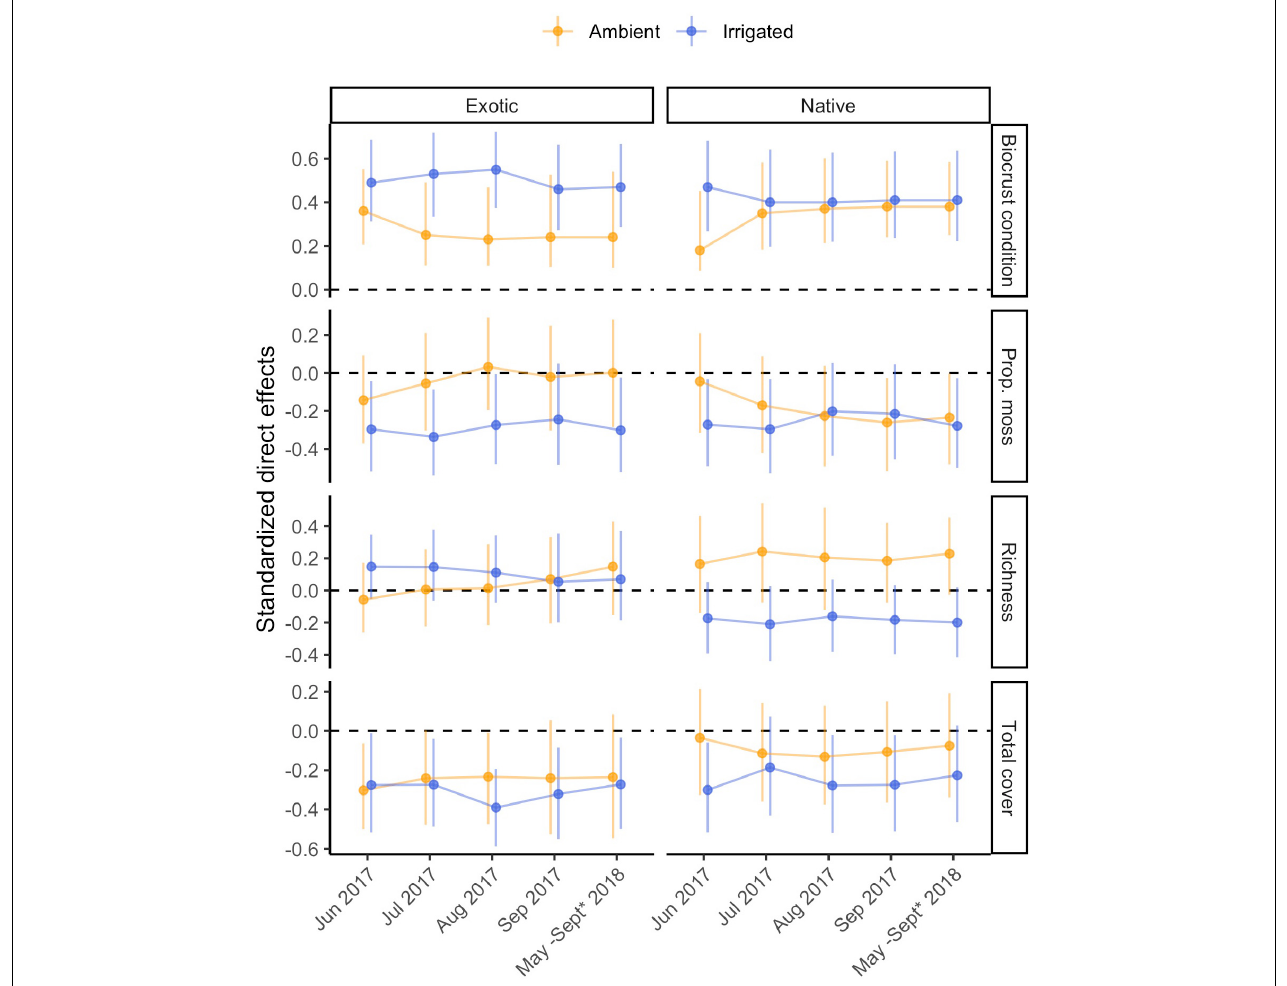
FIGURE 3 | Standardized direct effects of biocrust condition and biocrust properties on exotic and native plant emergence through time, under ambient and irrigated conditions. Error bars represent 95% bootstrap confidence intervals based on 5,000 bootstrap samples. * Monitoring of these data was discontinued in 2018, therefore all models used emergence data from the final 2017